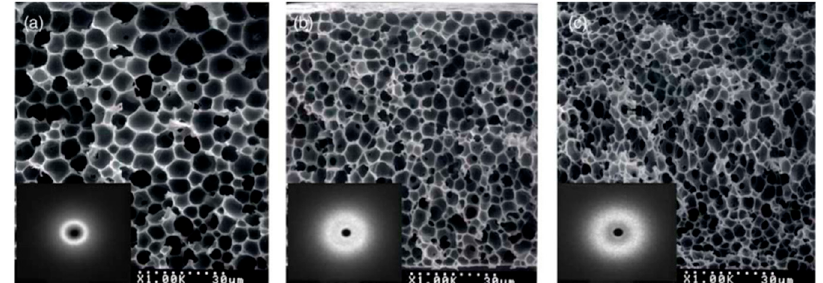
Figure 5. E ff ect of PS concentration on the membrane surface structure for di ff erent polymeric Figure 5. Effect of PS concentration on the membrane surface structure for different polymeric